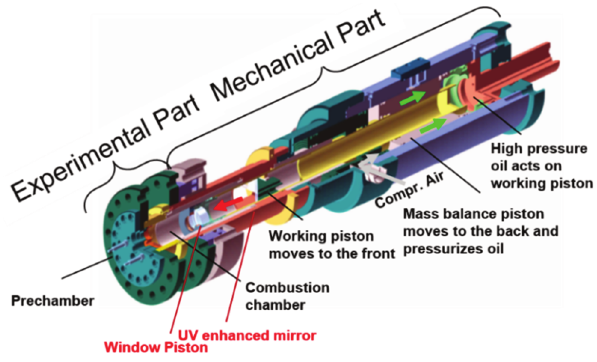
Fig. 1. Drawing of the RCEM, showing the most important components The RCEM bore diameter is B = 84 mm and the quartz piston has a top hat bowl shape with diameter of 52 mm and depth of 2.2 mm. The piston stroke is adjustable (s = = 120–250 mm), and for this study was set at maximum. The temperature of the cylinder head and liner was set to 383 K using different heating elements and measured by 6 K-type thermocouples. Differently than in an engine, the filling process of the RCEM cylinder is occurring well before the compression and thus no turbulence exists in the main chamber at the beginning of the stroke.